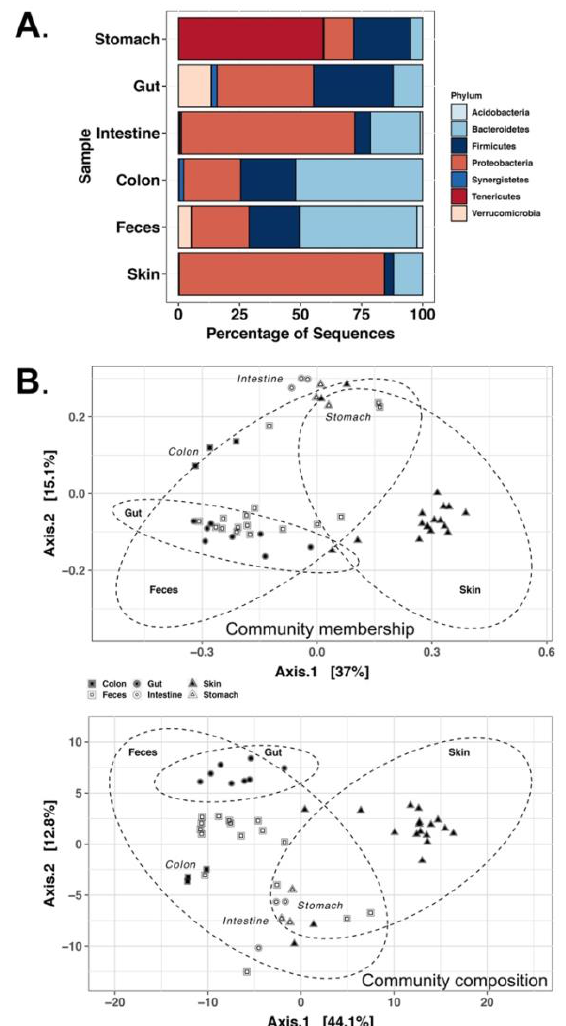
Figure 3. Xenopus microbiota across several adult organs and samples. A. Bar plot representation of bacterial diversity at the phylum level. B. Principal coordinate analysis of microbial communities across several adult organs and samples. Community membership was analyzed using unweighted UniFrac distance, and community structure was analyzed using weighted UniFrac distance. Percentages of the explained variations are indicated on both